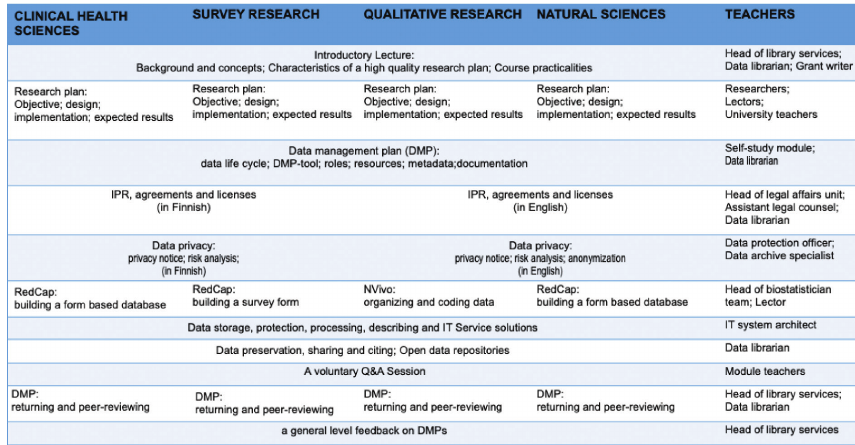
Table 1: The structure, contents, and responsible teachers of the four-track BRDM